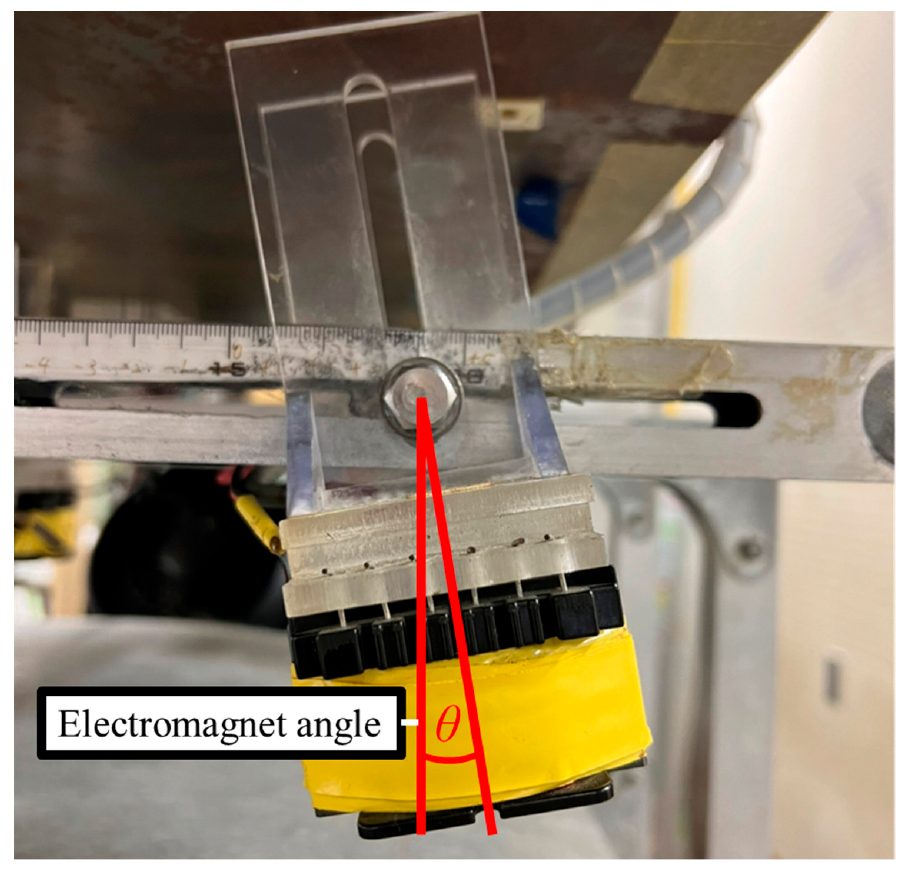
Figure 5. Photograph of an electromagnet angle.